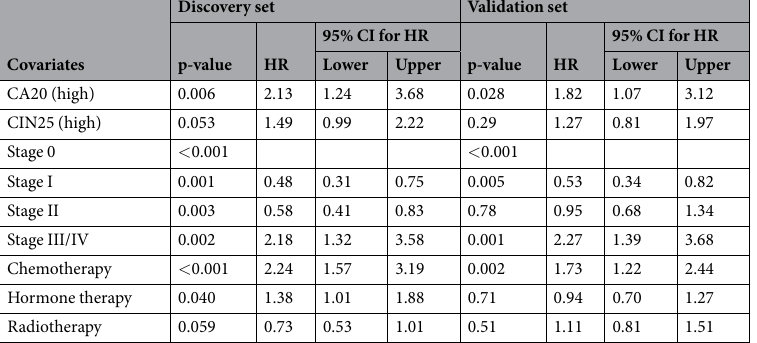
Table 4. Final multivariable Cox proportional-hazards models of breast cancer-specific survival including CA20 and CIN25 (based on optimal thresholds) in full models using METABRIC data. HR = Hazard Ratio; CI = Confidence Interval.